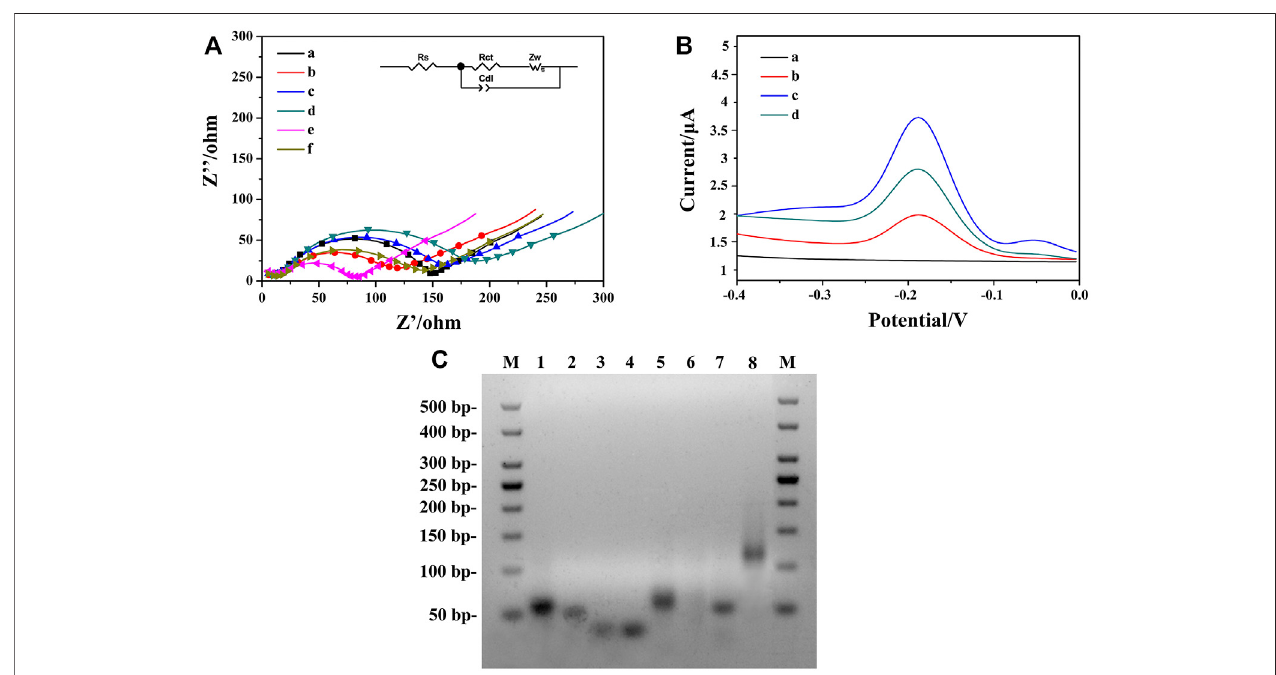
FIGURE4|(A) Nyquistplotsofdifferentmodi fi edelectrodes wererecordedinPBScontaining5.0 mM [Fe(CN) 6 ] 3 − / 43 − :(a)bare ITO,(b)AuNPs/ZIF-8/ITO,(c)HP1/ AuNPs/ZIF-8/ITO,(d)BSA/HP1/AuNPs/ZIF-8/ITO,(e)ssDNA/HP1/AuNPs/ZIF-8/ITO,(f)HCR/ssDNA/HP1/AuNPs/ZIF-8/ITO. (B) DPVsignalsinPBSat(a)ssDNA/HP1/ AuNPs/ZIF-8/ITO, (b) HCR/ssDNA/HP1/AuNPs/ZIF-8/ITO with Thi, (c) solution b added with NADH, Thi, and hemin, (d) HCR/ssDNA/HP1/AuNPs/ZIF-8/ITO formed aftertheadditionof10 3 fgml − 1 OTA. (C) TheAGEcharacterization.LaneM:DNAmarker,lanes1 – 4:HP,HP1,HP2,andHP3,respectively;lane5:HP/RNA;lane6: solution 5 added with DSN; lane 7: ssDNA/HP1; lane 8: